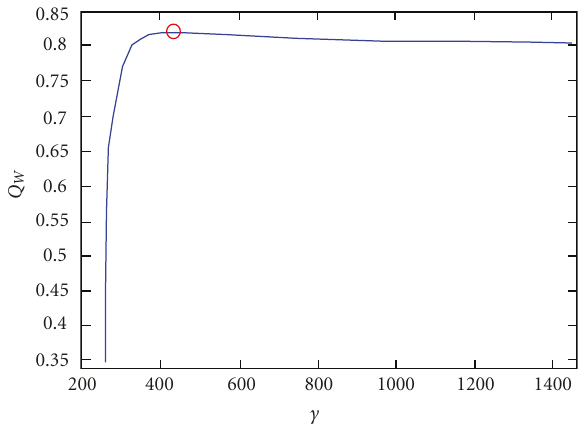
Figure 5: Plot of Q W versus γ for image fusion results in Figure 4, indicating a maximum at γ = 430, Q W = 0 .